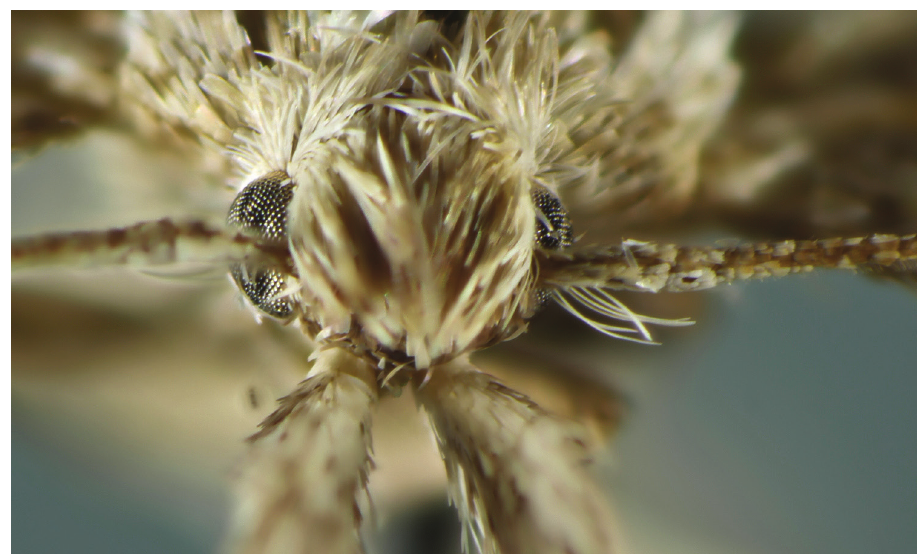
Figure 2. Adult head with pecten on antennal scape of Megacraspedus niphorrhoa (Meyrick,